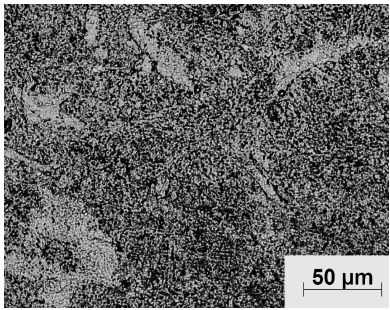
Figure 3. Light micrograph of the as-received Ti-6Al-4V.